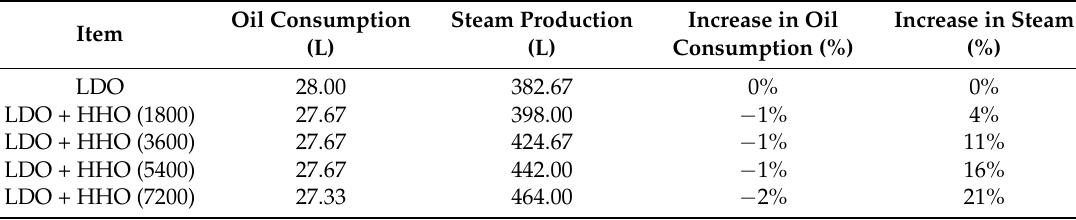
Table 10. Average increases (%) of LDO consumption and steam production when combining LDO with various amounts of